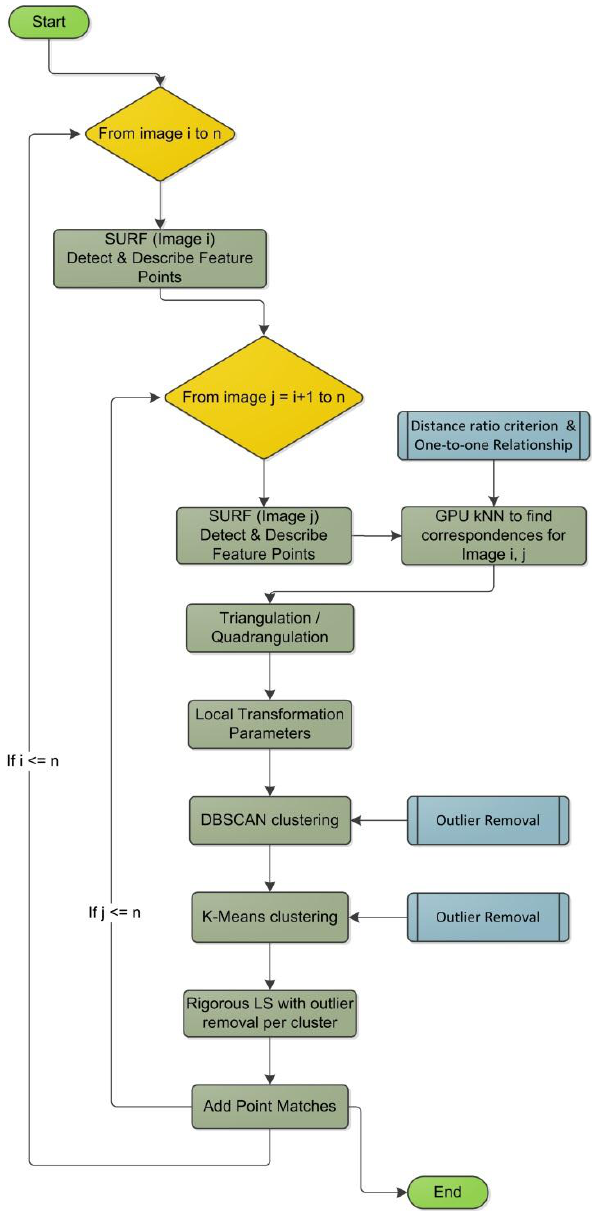
Figure 1. Flowchart of the proposed matching